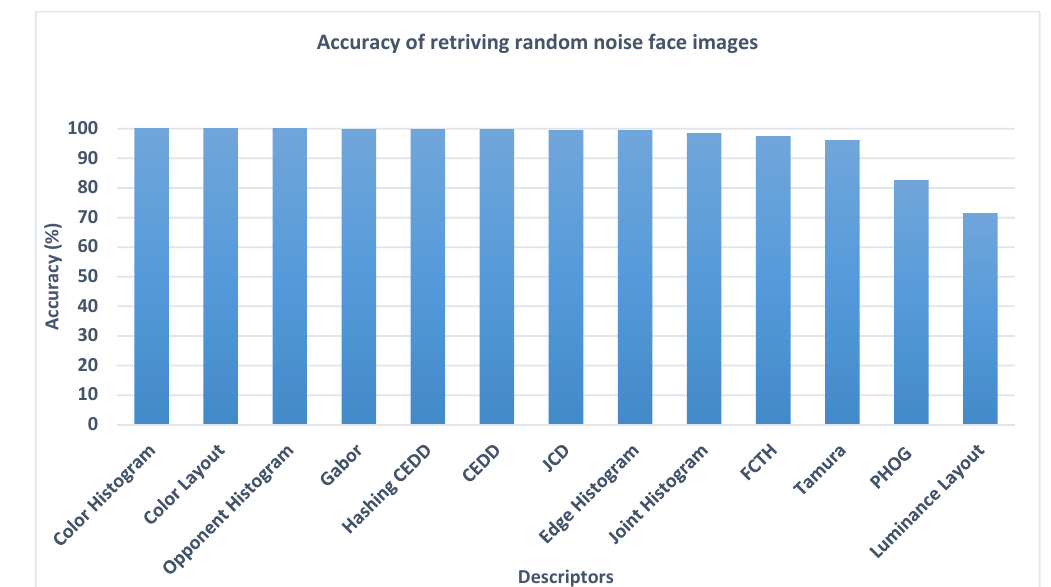
Figure 10. Critical Distance Diagram (CDD) for rotated face images.